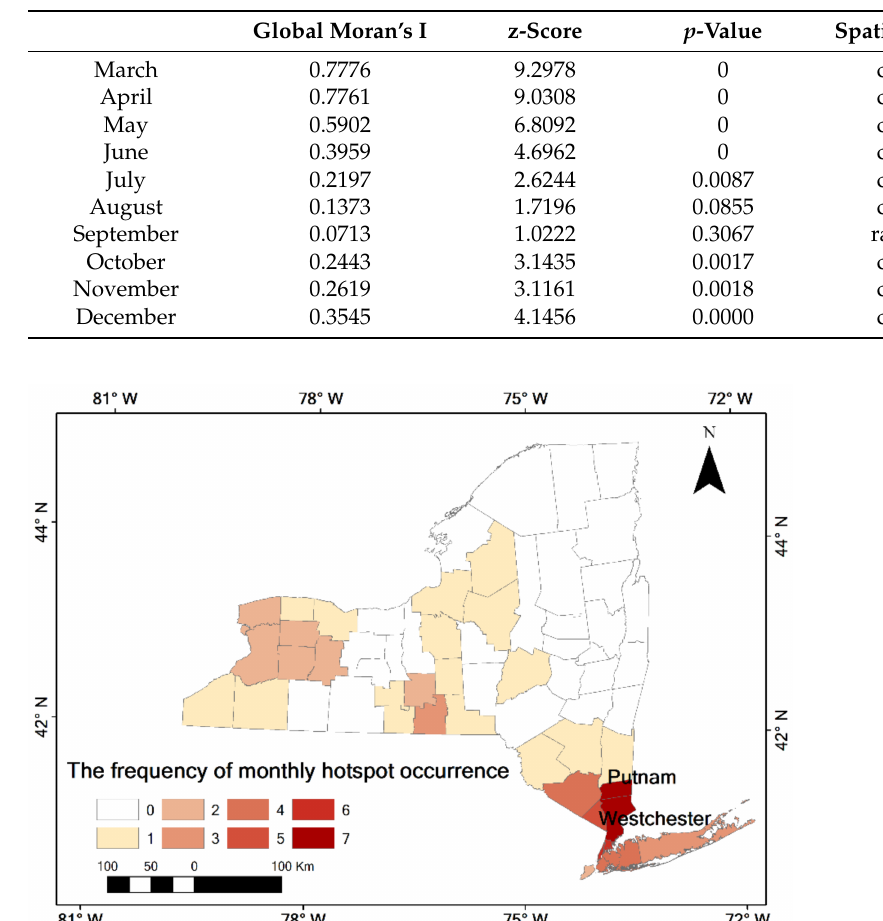
Table 3. Global Moran’s I analysis of COVID-19 incidence rate at the county level in New York State.